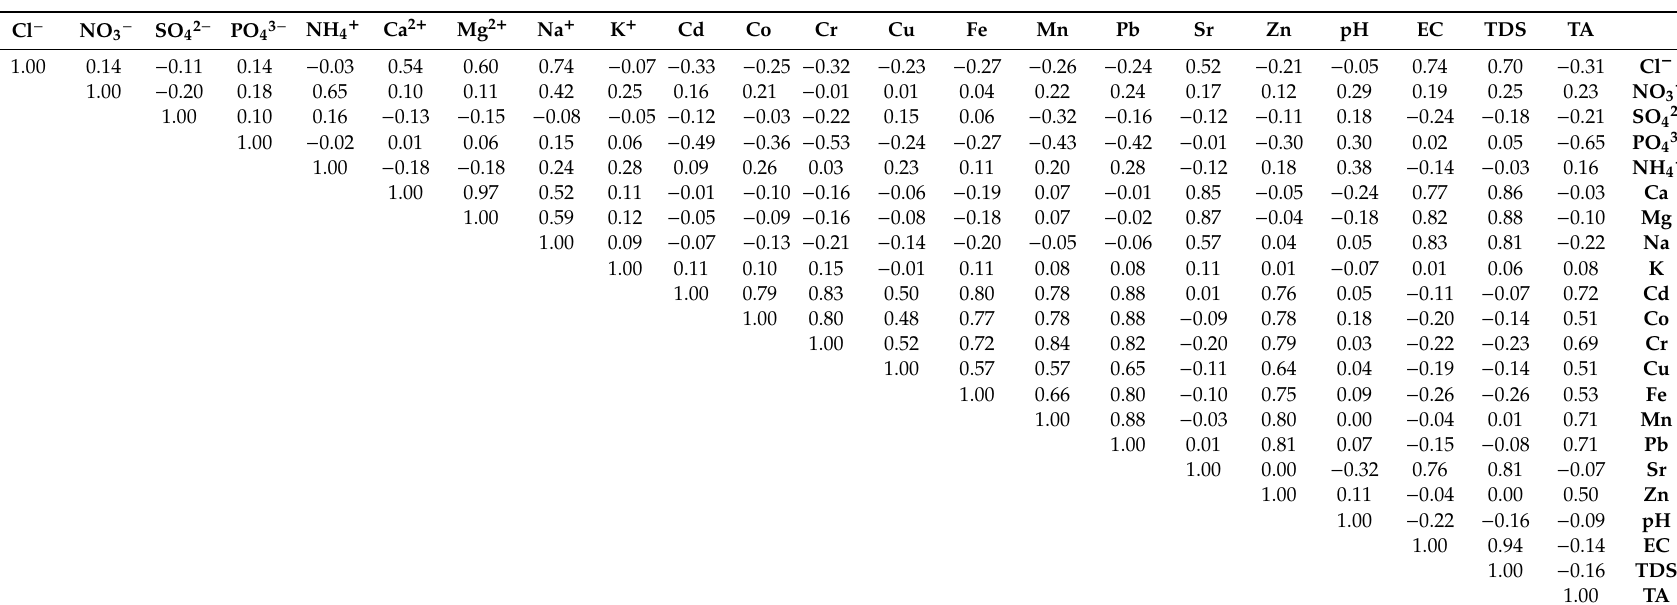
Table 2. Correlation matrices for surface water quality